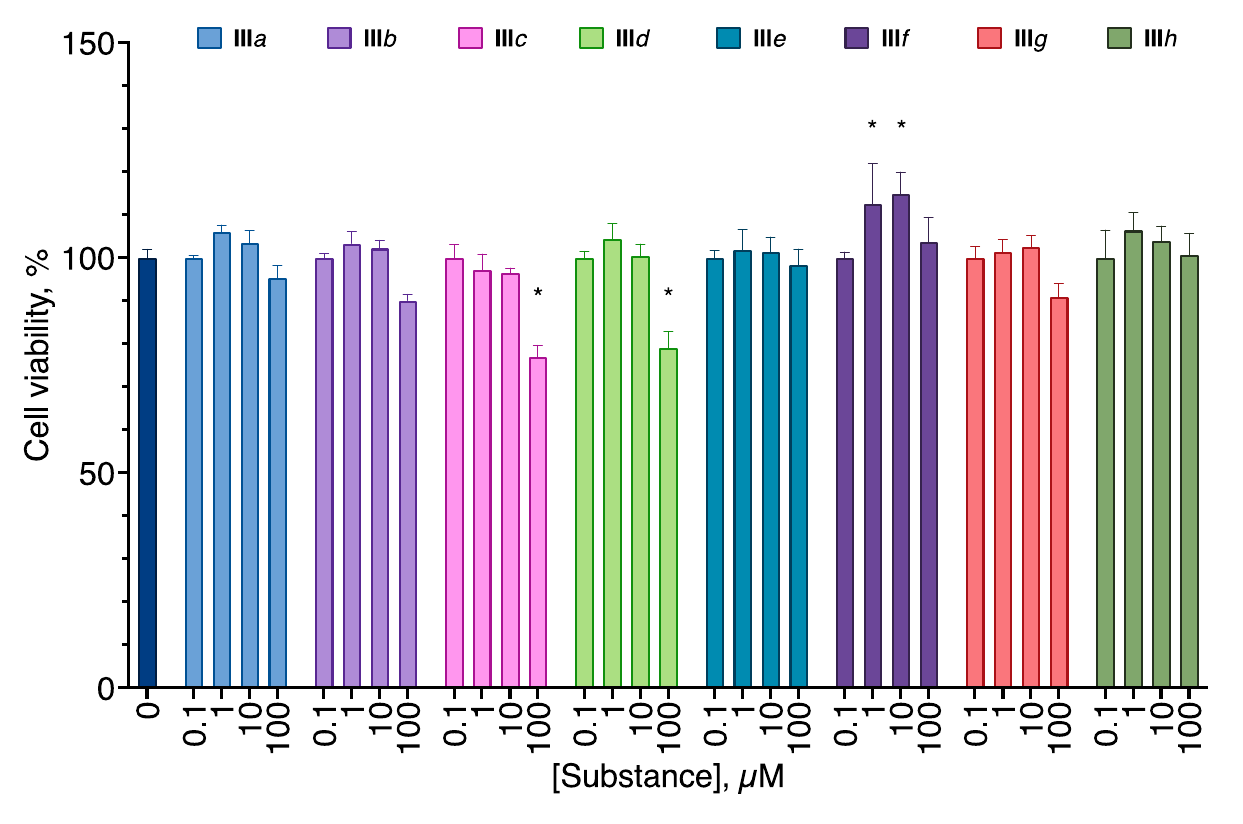
Figure 9. EDU analogs III effect on the proliferation of SH-SY5Y cell line in a prolonged incubation. Negative control cells (100% viability) were treated with 0.5% DMSO. Positive control cells (100% cell death) were treated with 3.6 µL of 50% Triton X-100 in ethanol per 200 µL of the cell culture medium. 72 h incubation time. MTT assay data, mean ± standard error, n = 3 amalgamated experiments. * Statistically significant difference from the control without substance. ANOVA with the Dunnett post-test, p ≤ 0.05.